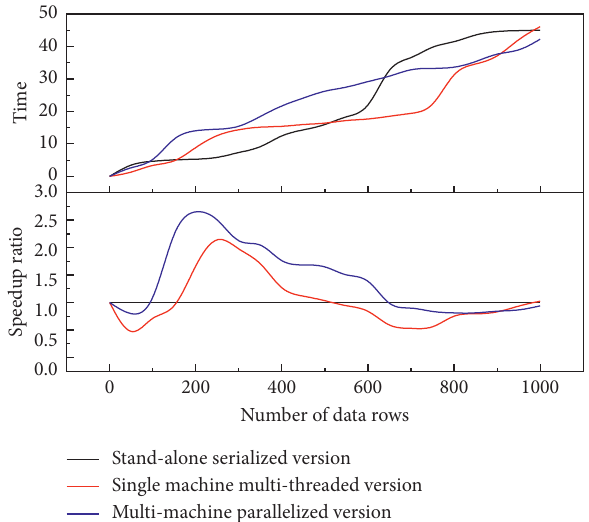
Figure 6: Experiment comparing the performance of parallelized data type detection algorithm with its standalone version.